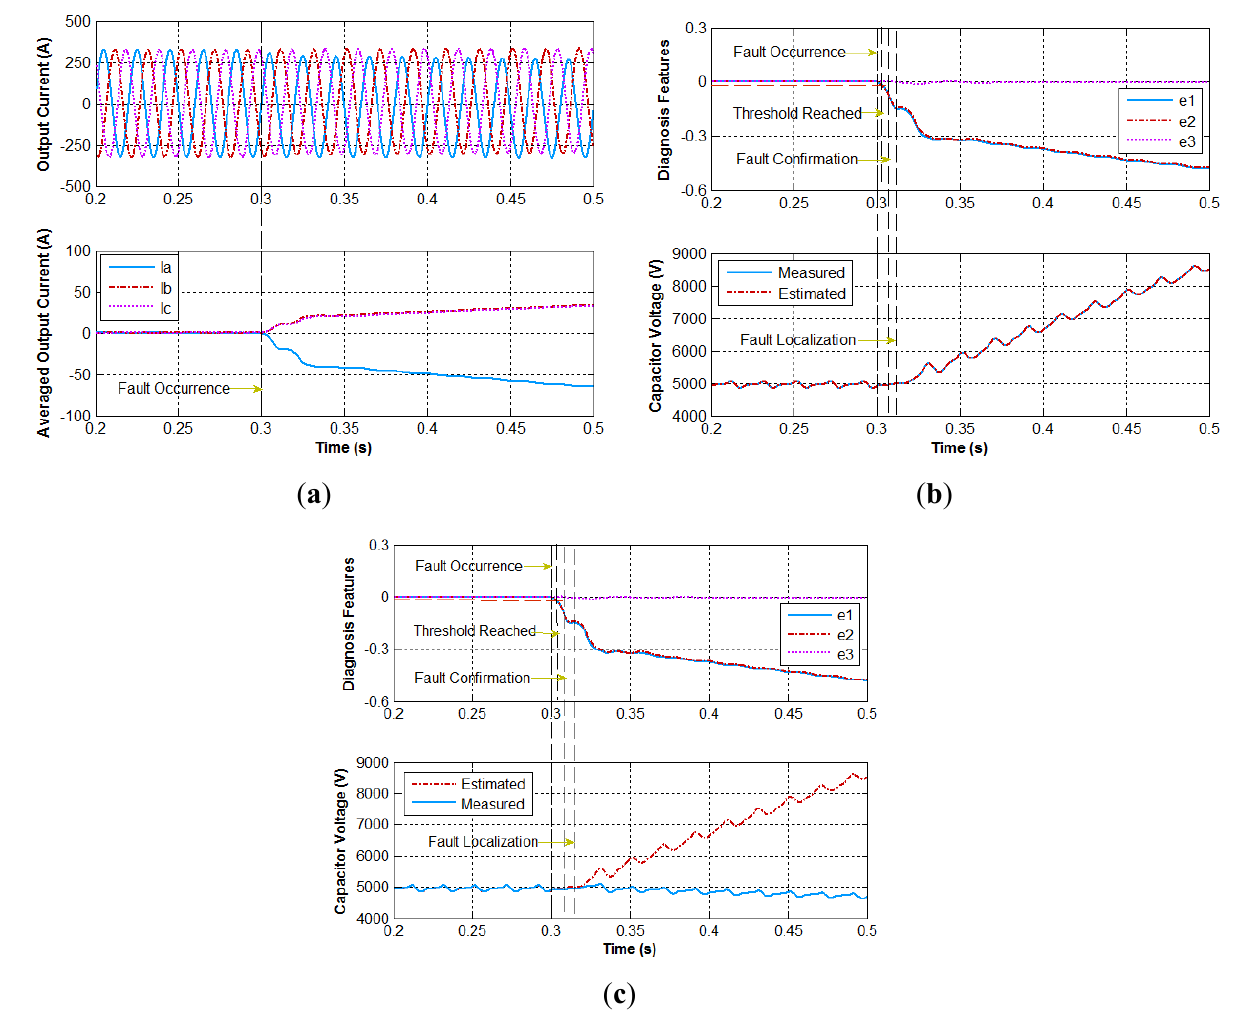
Figure 13. Open-circuit fault in T 2 under 10MW. ( a ) Output current and their averaged values; ( b ) Diagnosis features and capacitor voltages in SM1; ( c ) Diagnosis features and capacitor voltages in